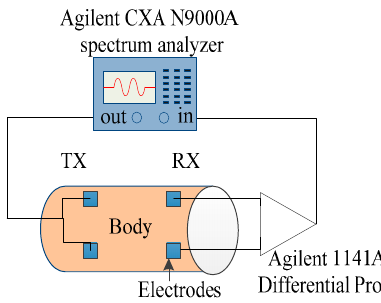
Figure 3. Experimental setup for the body channel measurement, Agilent CXA N9000A spectrum analyzer as a transmitter, Agilent 1141A differential probe and spectrum analyzer as a receiver.